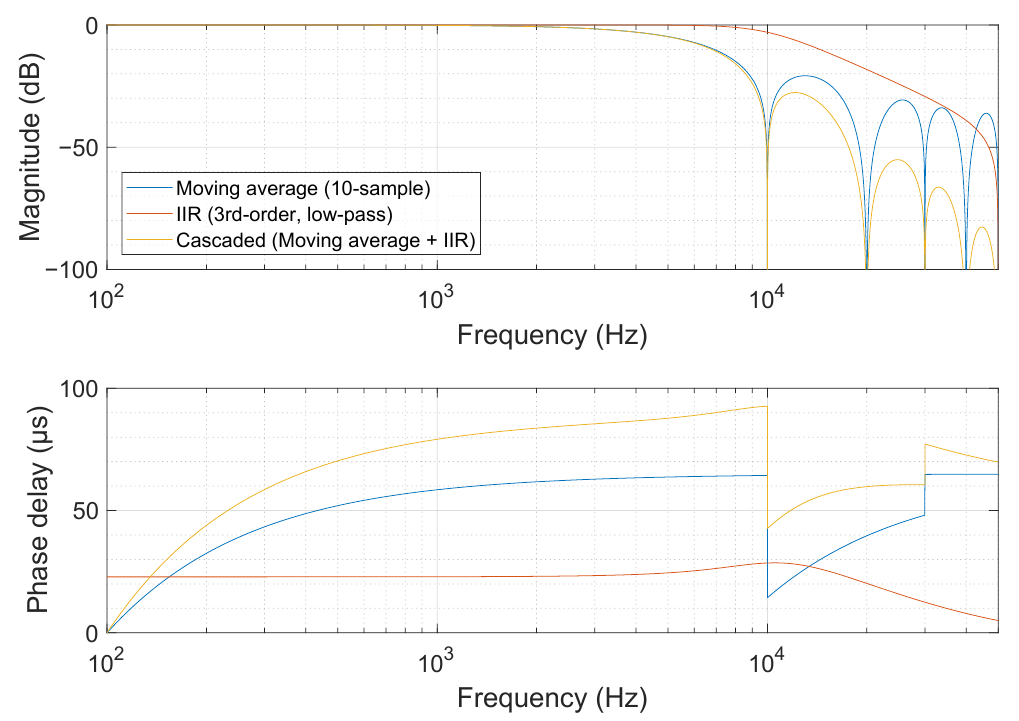
Figure 8. Magnitude response and phase delay of the digital low-pass filters filtering the measure- ment signal during demodulation. Filtering consists of a 10-sample moving average filter combined with a 3rd-order low-pass IIR filter operated at 100 kHz sampling frequency. The filtering results in a 4 kHz − 3 dB cut-off frequency with 87 µs phase delay at the cut-off